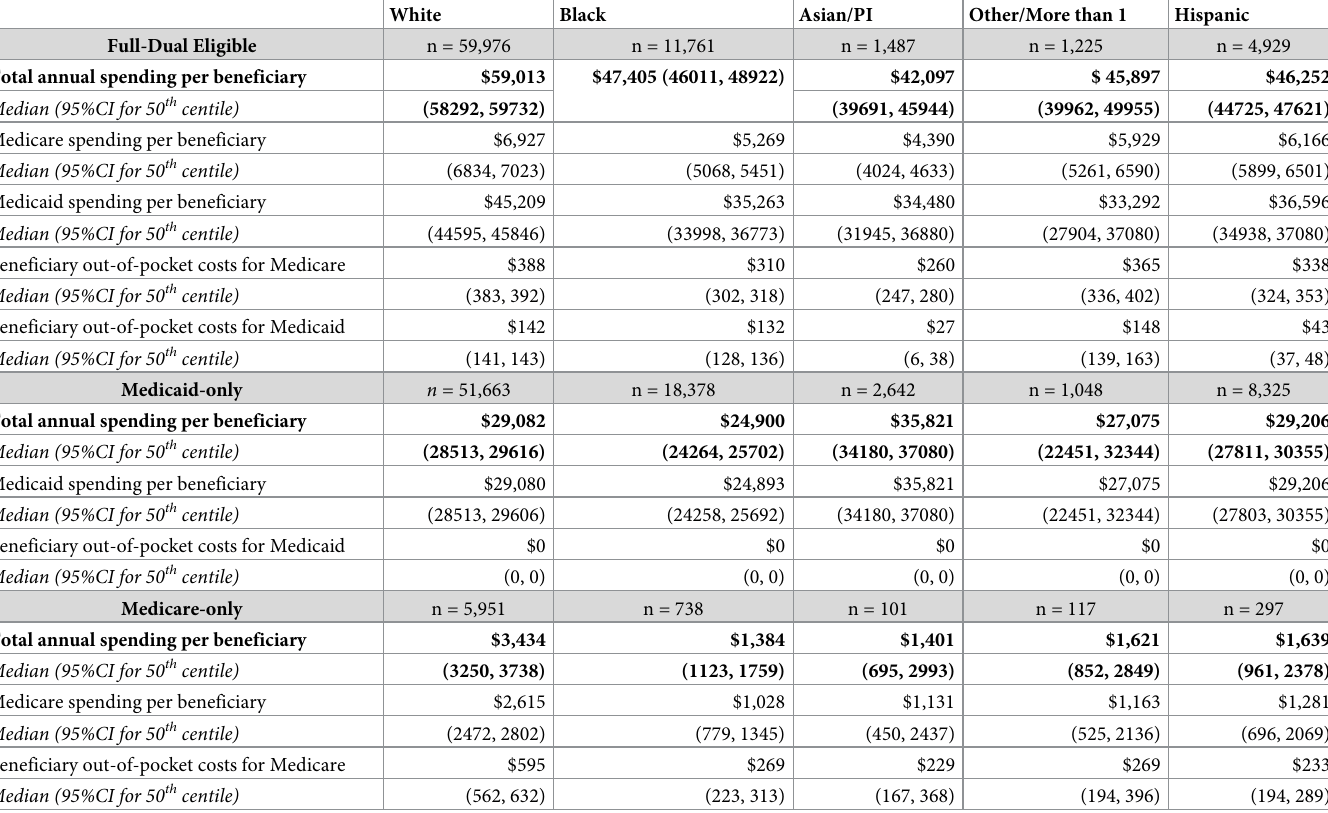
Table 3. Median annual per beneficiary spending in 2012 by race-ethnicity among autistic